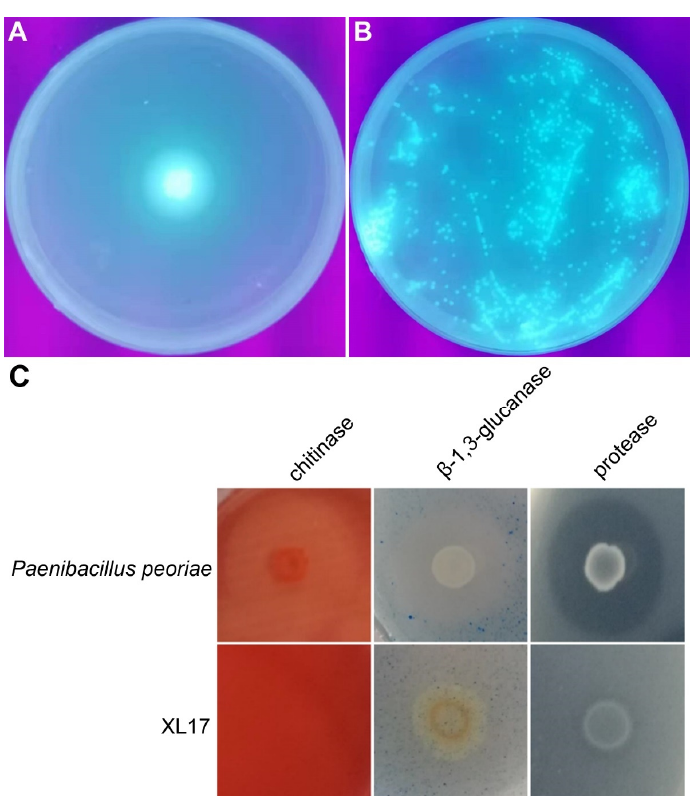
Figure 9. Agar plate assays show bacterial production of fluorescent pyoverdine siderophore and hydrolysis of chitin, β -1,3-glucan, and casein by bacterial chitinase, β -1,3-glucanase, and protease. ( A ) XL17 cells dropped at the center of the King’s B agar plate grow and secrete fluorescent pyover- dine siderophore appearing under UV light. ( B ) XL17 cells spread on the Kings’ B agar plate grow to colonies showing fluorescence. ( C ) Paenibacillus peoriae CGMCC 1.3761 T used as positive control hydrolyses chitin, β -1,3-glucan, and casein while strain XL17 weakly hydrolyses β -1,3-glucan and casein.